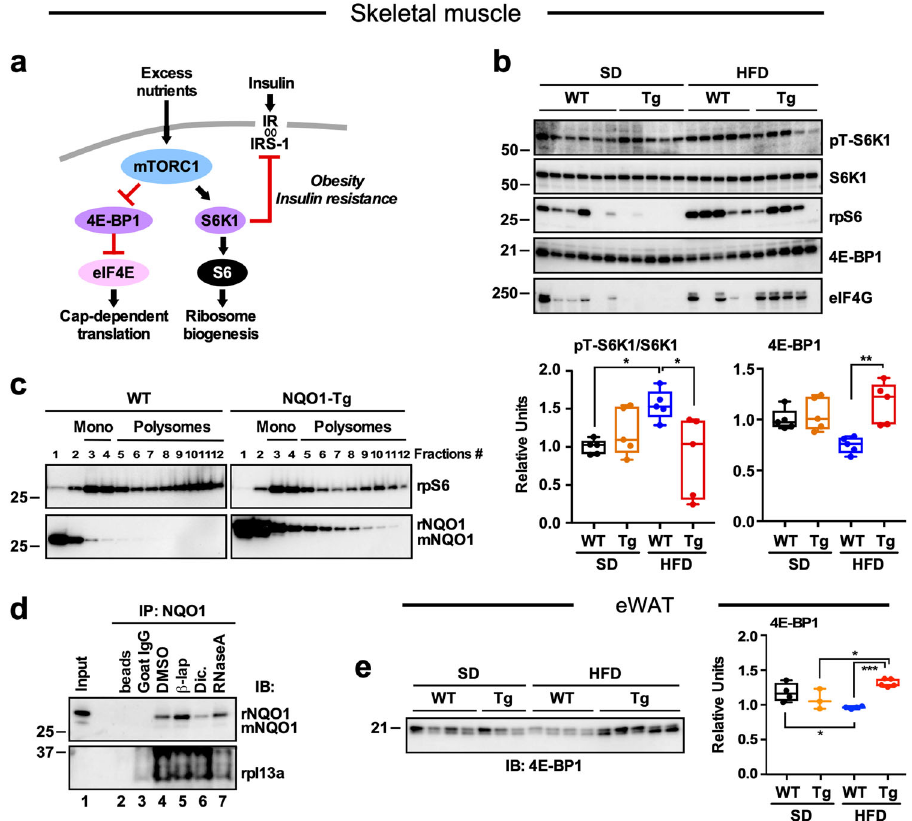
Fig. 4 Effect of NQO1 transgenesis on downstream effectors of mTORC1 and translation machinery. a Diagram depicting the impact of excess nutrients on mTORC1 pathway activation and associated inhibition of insulin signaling. b Top panel , Skeletal muscle extracts from Fig. 3a were rerun and probed with antibodies against key downstream effectors of mTORC1, namely the phosphorylated and total forms of S6K1, ribosomal protein S6 (rpS6), 4E-BP-1, and eIF4G protein. Bottom panel , densitometric quanti fi cation of the phospho-active/total ratio of S6K1 and of 4E-BP1. Values are represented as boxplots with individual values ( n = 5 per group). c Sucrose gradient fractionation of pooled cytosolic quadricep extracts from WT and NQO1-Tg mice on HFD. Fractions were resolved by SDS-PAGE and immunoblotted for rpS6 and NQO1 proteins. Monosomes are found in fractions 3 – 4, and polysomes in fractions 5 – 12. d NQO1:protein complexes in skeletal muscle homogenates were immunoprecipitated with goat anti-NQO1 antibody. Immunoprecipitates were incubated with DMSO, 10 μ M beta-lapachone ( β -lap.), extracts from Fig. 3e were rerun and probed with anti-4E-BP1 antibody. Right panel , densitometric quanti fi cation. *, **, *** p < 0.05, 0.01,